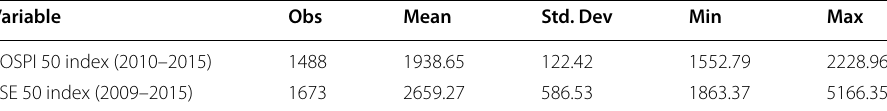
This table reports the means, standard deviations, maxima, and minima of KOSPI 50 and SSE 50 indices over the data period